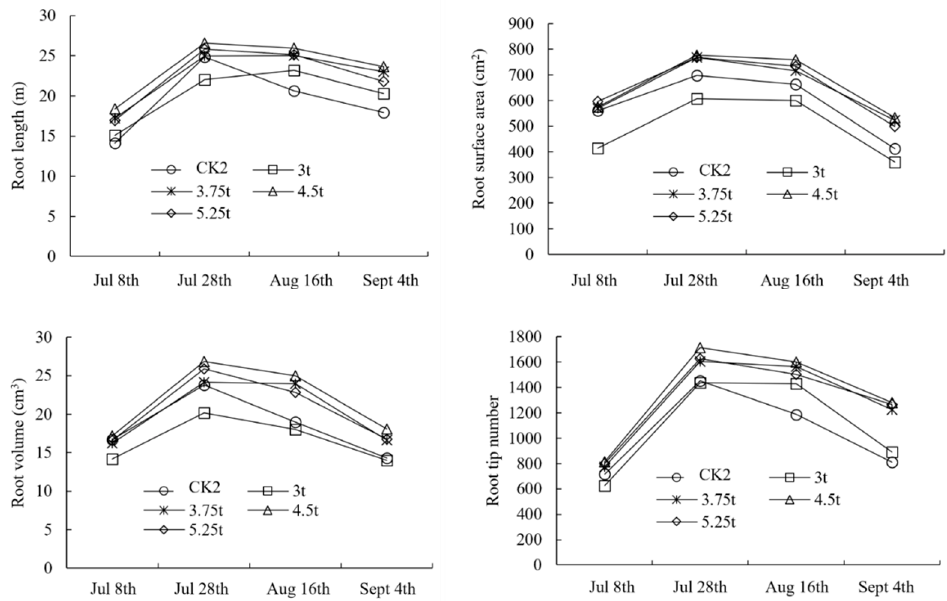
Figure 1. Effects of the carbon-based fertilizer on maize root morphology (taking Jingke 968 as an example).